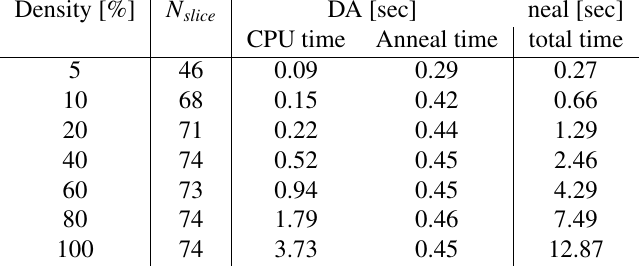
Table 1: A comparison of the compute time of the Digital Annealer and the neal solver. N slice is the number of η slices. A queue and network time of the Digital Annealer are not included in this